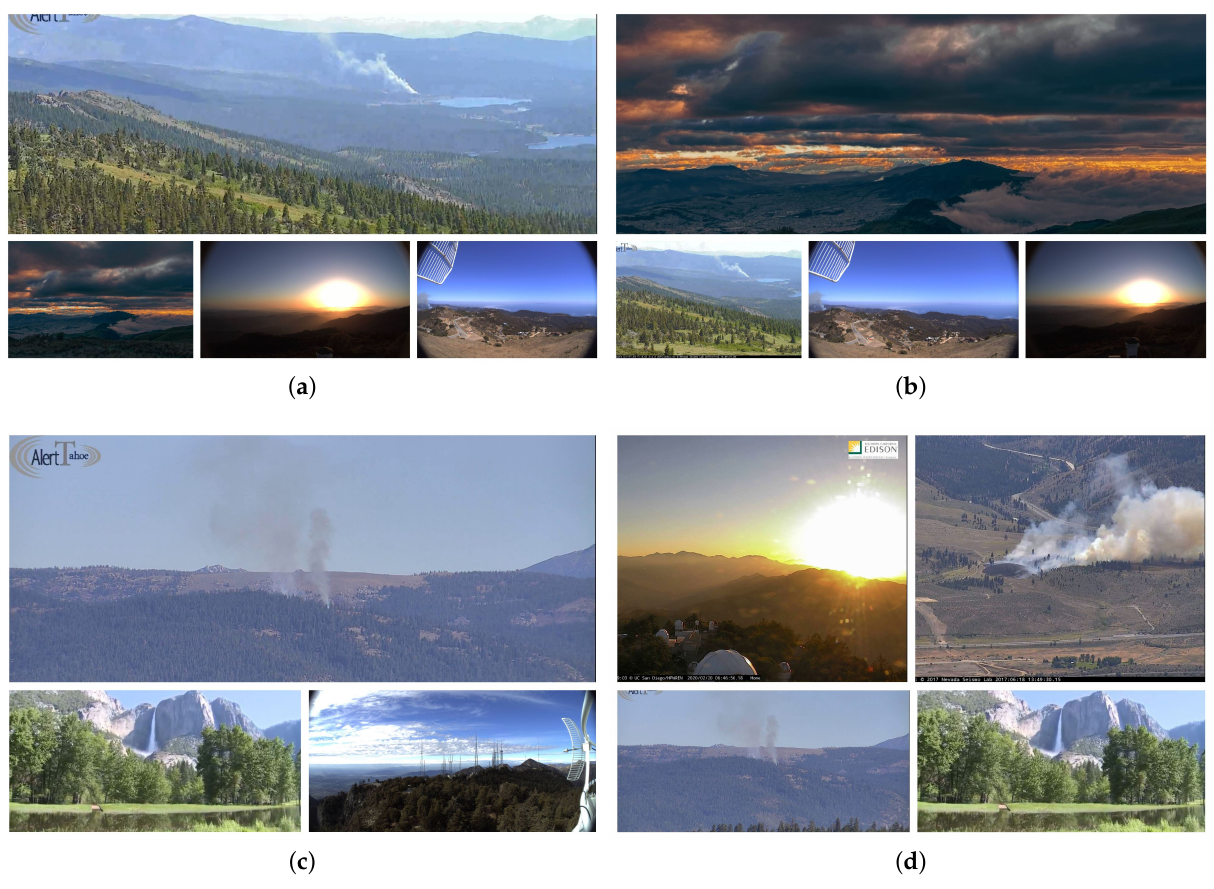
Figure 10. Four representative examples of collage images used for training. Different configurations were used (e.g., 1 by 1, 1 by 2, 2 by 1, 2 by 2, 1 by 3, etc.). The images within the collages were often reused, but shifted to create variability and avoid learning bias. ( a , b ) are permutations of the same set of images. In ( a ), the bottom-right and top images have smoke, and the other images are used as new background samples. ( c ) Collage of three images, with a larger image containing smoke and two smaller images containing non-smoke background. ( d ) The top-right and bottom-left are images containing smoke, and the top-left is a shade of sunrise that our initial training had never seen due to a lack of incipient-stage smoke happening naturally in such a